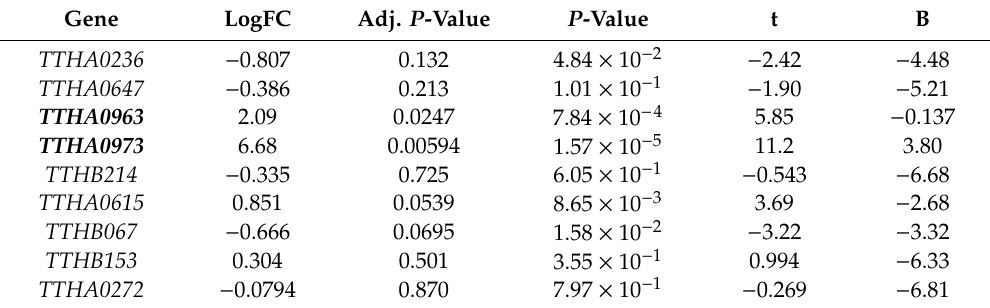
Table 4. GEO2R analysis comparing TTHA0973-deficient and wild type T. thermophilus HB8 gene expression